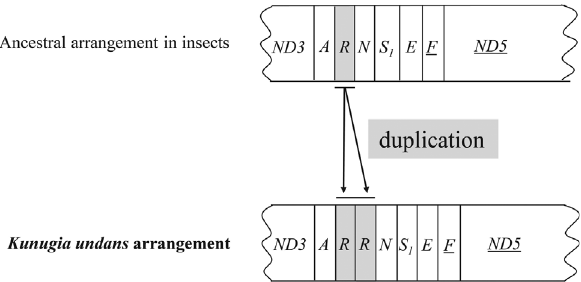
Figure 1 - Schematic illustration of the gene arrangement with the dupli- cated trnR detected in Kunugia undans . Gene sizes are not drawn to scale. Gene names that are not underlined indicate a forward transcriptional di- rection, whereas underlined sequences indicate a reversed transcriptional direction.tRNAsaredenotedbyone-lettersymbolsinaccordancewiththe IUPAC-IUB single-letter amino acid codes. The remaining genes and gene order configurations that are identical to ancestral insects are omit-